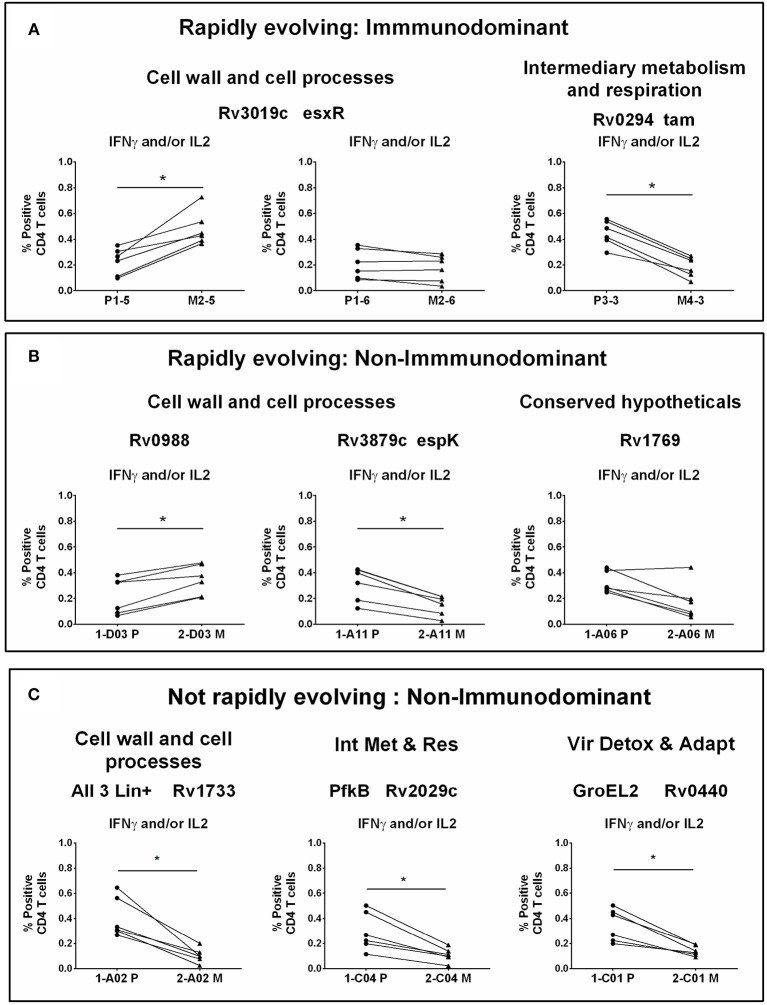
CD4 T cell responses to parent and mutant peptides. PBMCs from IGRA+ subjects were stimulated overnight with parent and mutant peptides that are either rapidly evolving or not-rapidly evolving and belonging to immunodominant and non-immunodominant category. Frequencies of IFNγ+ and/or IL2+ CD4 T cells were determined by ICS assay (see methods). Line graphs shows IFNγ and/or IL2 CD4 T cell frequency following stimulation with a set of nine parent and mutant peptides as individual plots in IGRA+ subjects after subtraction of background unstimulated control. Each line is a donor. Statistical analysis was performed using nonparametric Wilcoxon matched-pairs signed rank test. *P < 0.05 was considered significant. mTCE were grouped as follows: (A) Rapidly evolving and immunodominant Rv3019c (EsxR) and Rv0294 (tam). (B) Rapidly evolving and non-immunodominant Rv0988, Rv3879c (espK) and Rv1769. (C) Not rapidly evolving and non-immunodominant Rv1733, Rv2029c, and Rv0440.